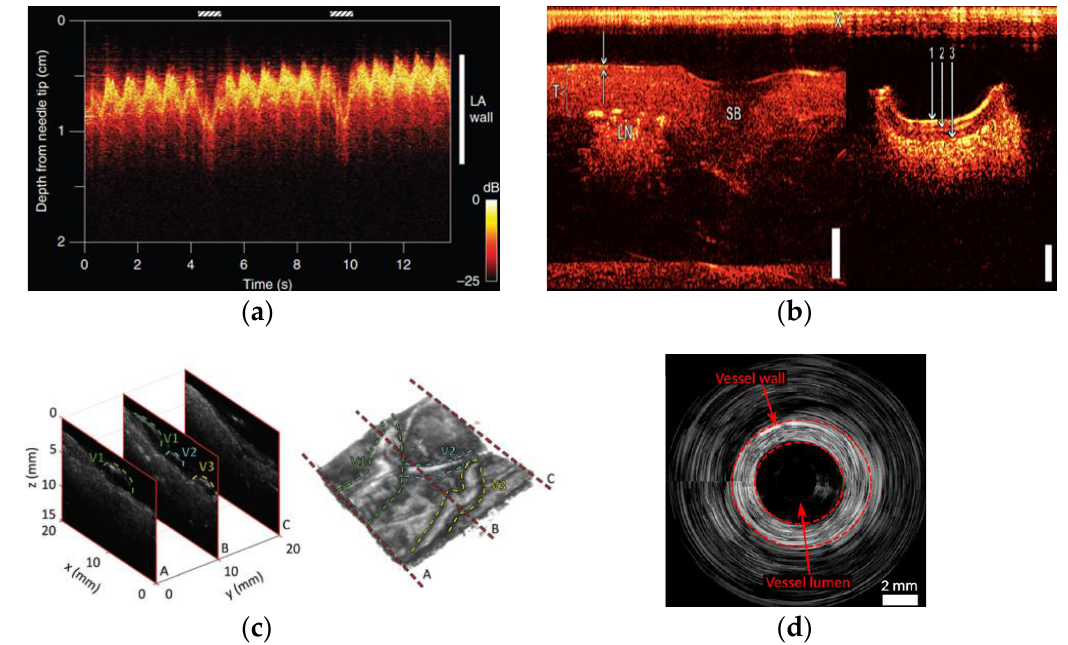
Figure 1. Images generated with photoacoustic-based ultrasound probes. ( a ) Left atrium (LA) wall M-mode image of a swine’s heart; ( b ) 2D images of aorta (left) and carotid artery (right) of swine samples (scale bar: 2 mm); ( c ) 2D images of an ex vivo piece of normal term human placenta (left) and 3D rendering of the reconstructed image (right); ( d ) B-mode intraluminal imaging of a swine carotid artery. Reproduced with permission from [1,59 – 61].